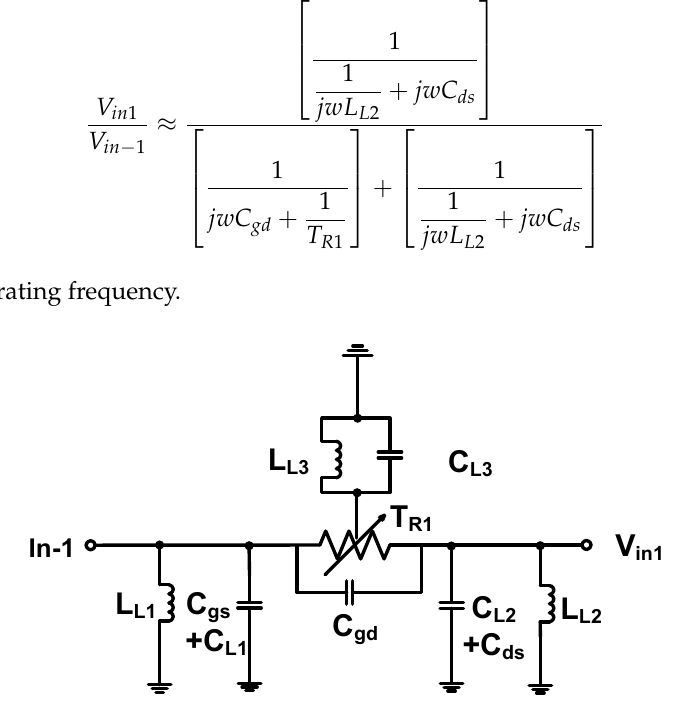
Figure 3. The equivalent circuit model of the power MOSFET linearizer.